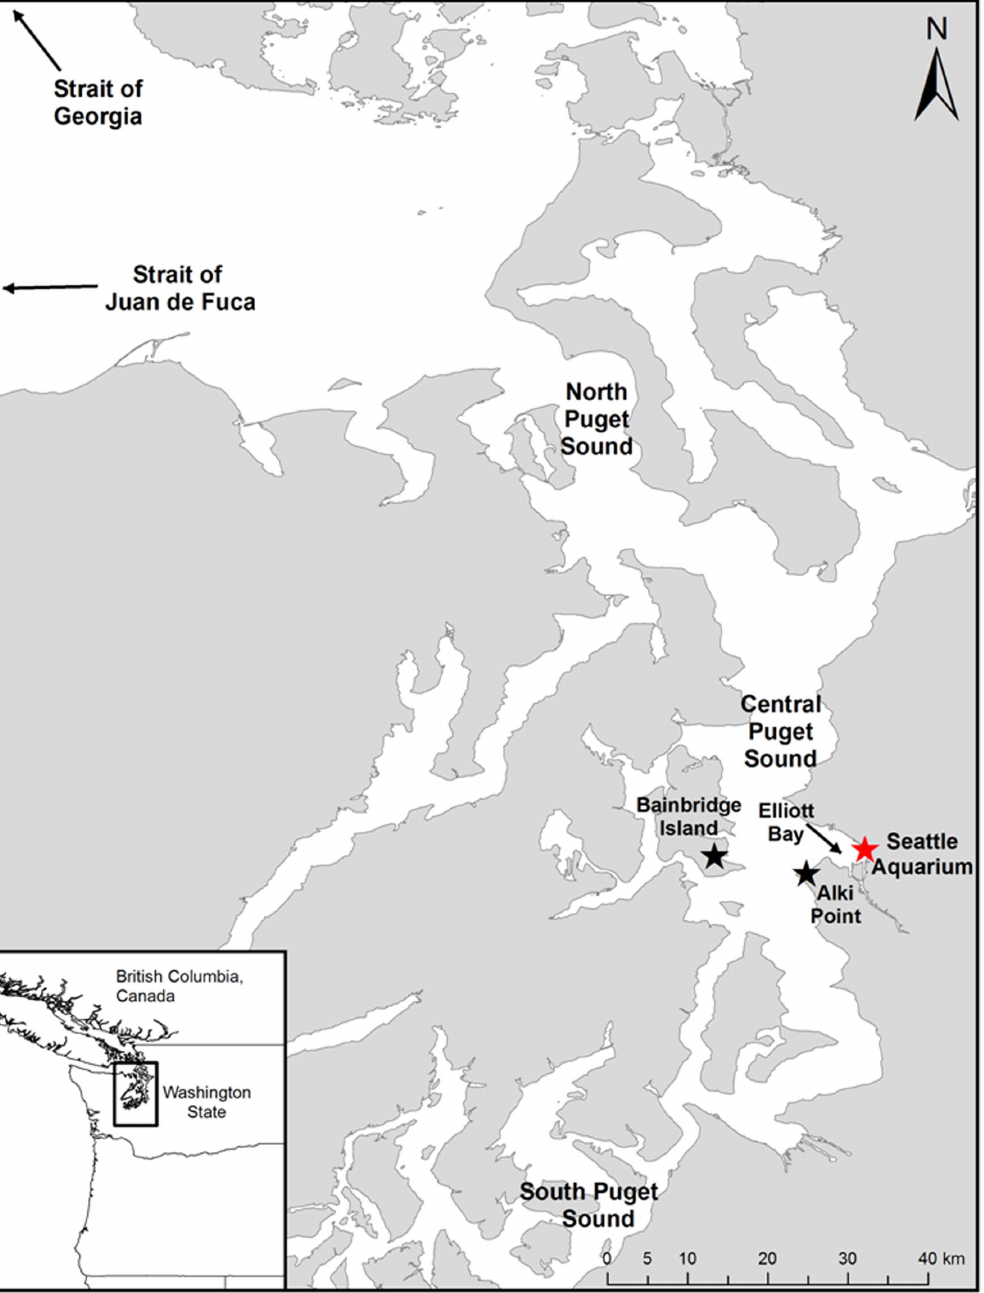
Figure 1. Map of Puget Sound. The location of the Seattle Aquarium is marked with a red star. doi:10.1371/journal.pone.0087081.g001 using visual tags (Floy VM69 stainless-steel dart tags) extended in length to 30 cm and modified to contain unique shape combina- tions for individual identification of sharks. Four different plastic shapes (circle, square, triangle, and cross), each approximately 2.5 cm square, were attached to the streamer in up to four locations to yield 256 possible tag combinations. The tags were also imprinted with SA contact information in the event of retrieval by divers or fishermen. Divers attached the visual tags using a pole spear as sharks approached during baiting operations.